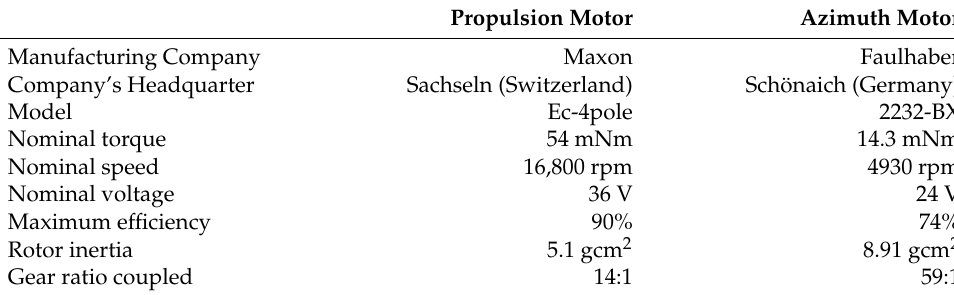
Table 5. Performance features of the two electric